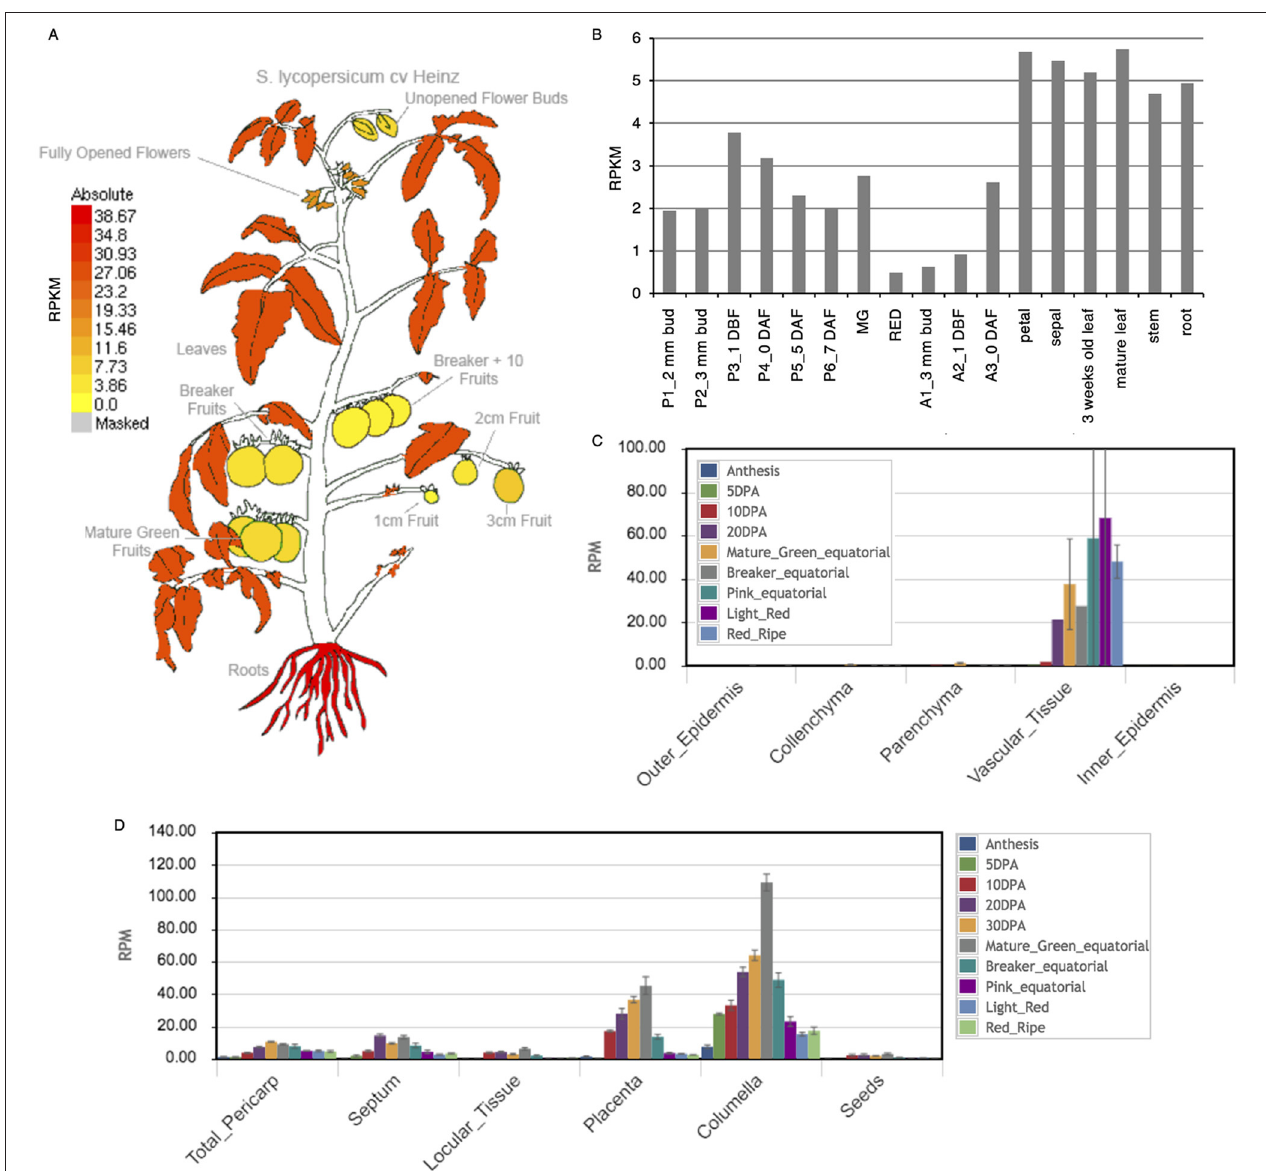
Supplementary Figure 7 | Spatiotemporal expression pattern of SPFF in various tomato organs, tissues and cells. (A) Expression images of SPFF , visualized in Tomato eFP browser (Winter et al., 2007), at tomato plant cv. Heinz 1706 organs (The Tomato Genome Consortium, 2012). (B) Expression pattern of SPFF in organs and inflorescence tissues of cv. Micro-Tom (Ezura et al., 2017). P1-6, pistil samples; MG, mature green fruits at 33 days after flowering; RED, red fruits at 44 days after flowering; A1-3, anther samples; DBF, days before flowering; DAF, days after flowering. SPFF mRNA expression pattern in fruit pericarp cell/tissue (C) and fruit